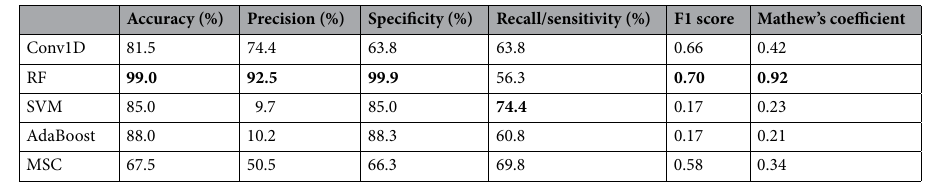
Table 2. Different evaluation metric values for the different machine learning models from Step 1 of Experiment 1.1. The highest value for each column (aka. evaluation metric) is boldfaced. Highest values obtained are in bold.